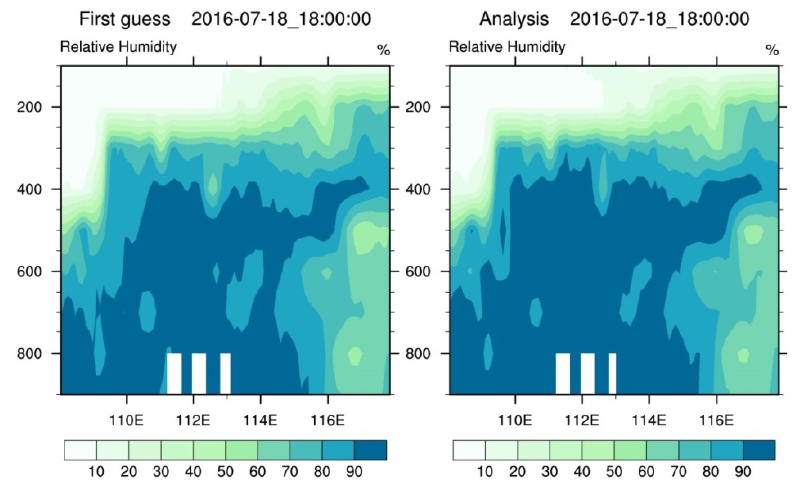
Figure 12. Cross sections of relative humidity (%) along 38.5 °N for the first guess and the analysis at 1800 UTC 18 July 2016.